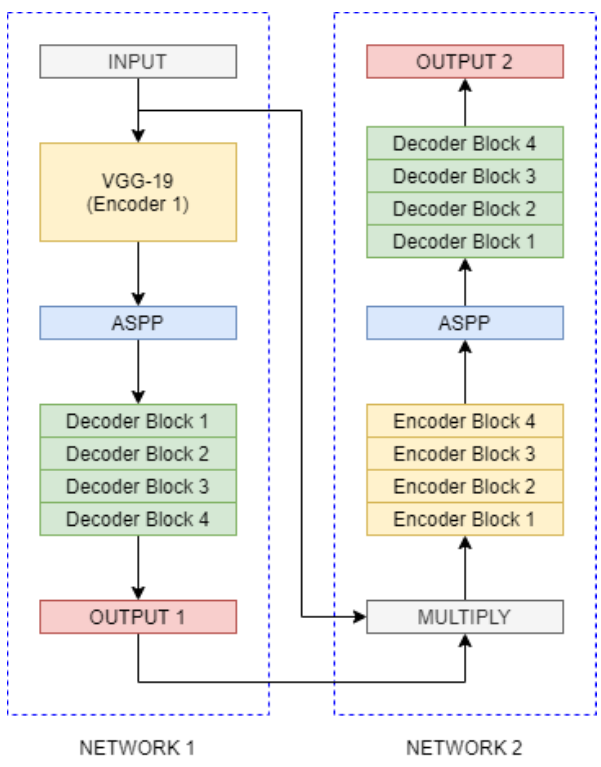
Figure 3. DoubleU-Net architecture (adapted from